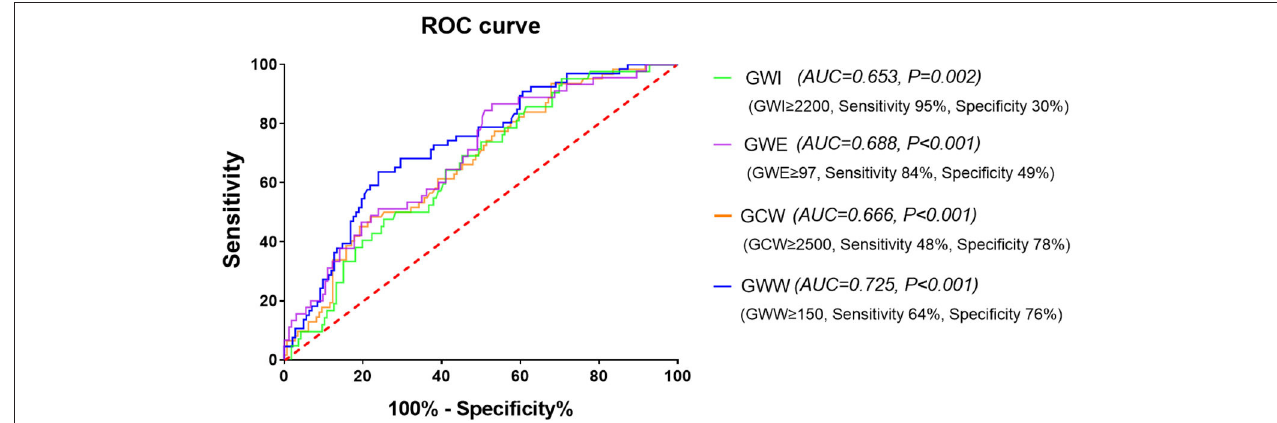
FIGURE 4 | The receiver operating characteristic (ROC) curve of baPWV for predicting the four abnormal components of MW. baPWV, brachial-ankle pulse wave velocity; GCW, global constructed work; GWE, global work efficiency; GWI, global work index; GWW, global wasted work; MW, myocardial work.